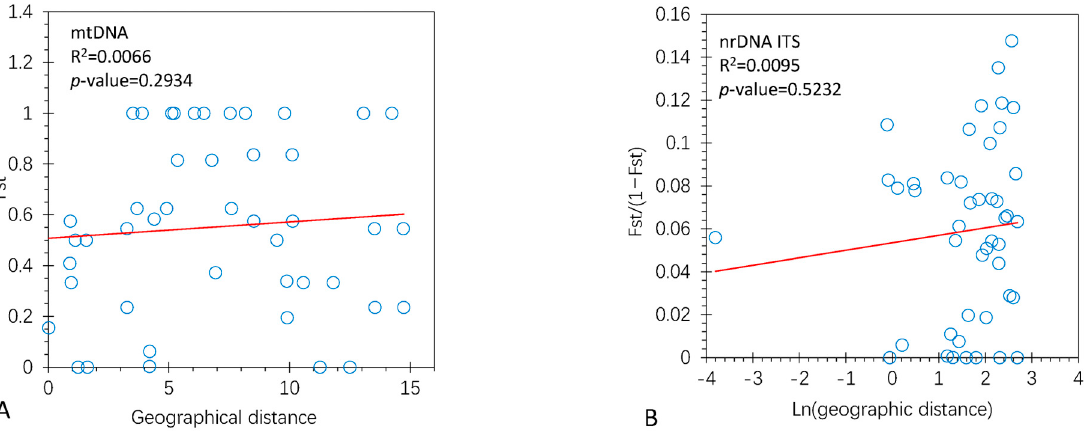
Figure 3. Effects of isolation by distance (IBD) on population genetic differentiation. ( A ) Pearson correlation between F st and geographic distance for the mtDNA markers. ( B ) The regression analysis of F st /(1 − F st ) on geographic distance for the nrDNA ITS